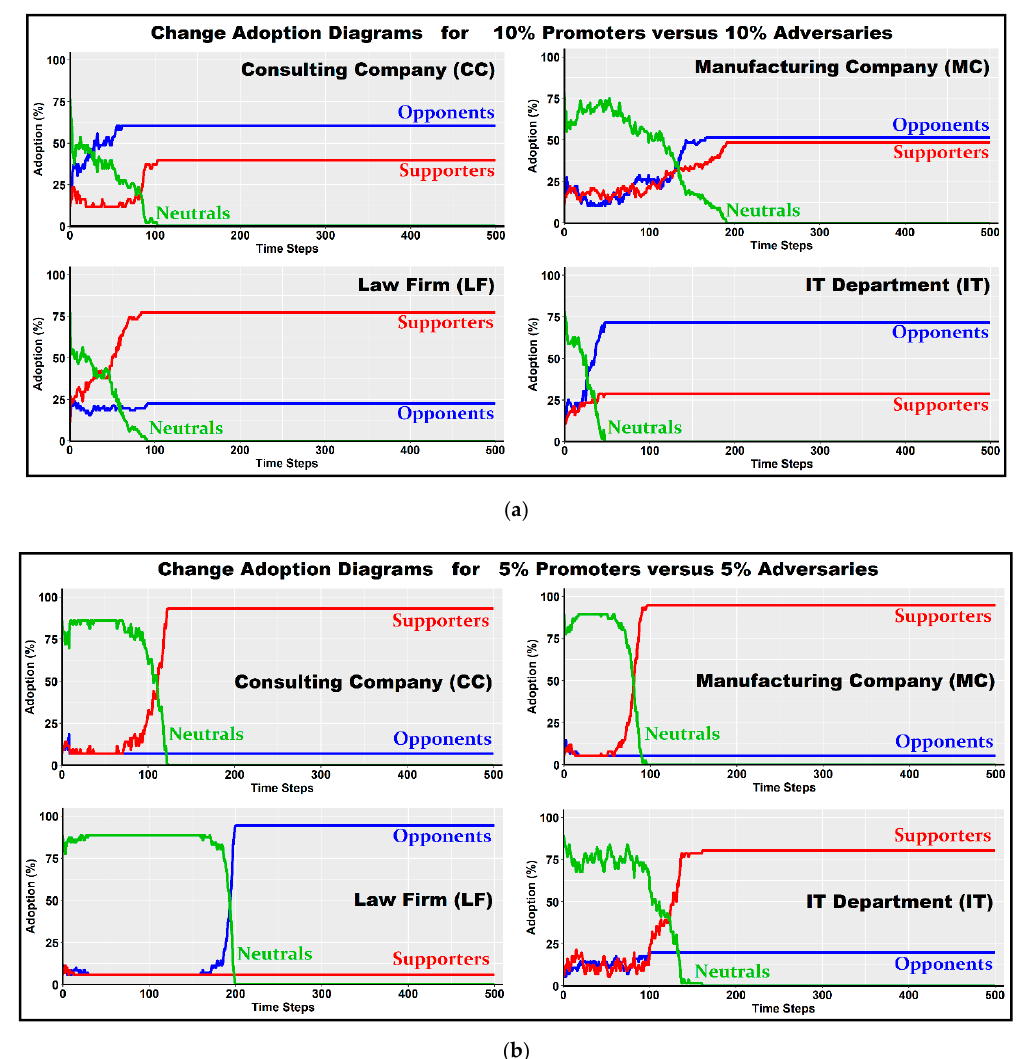
Figure 3. ( a ) Change adoption diagrams for the 4 real organizational networks, corresponding to Figure 2a. ( b ) Change adoption diagrams for the 4 real organizational networks, corresponding to Figure 2b.